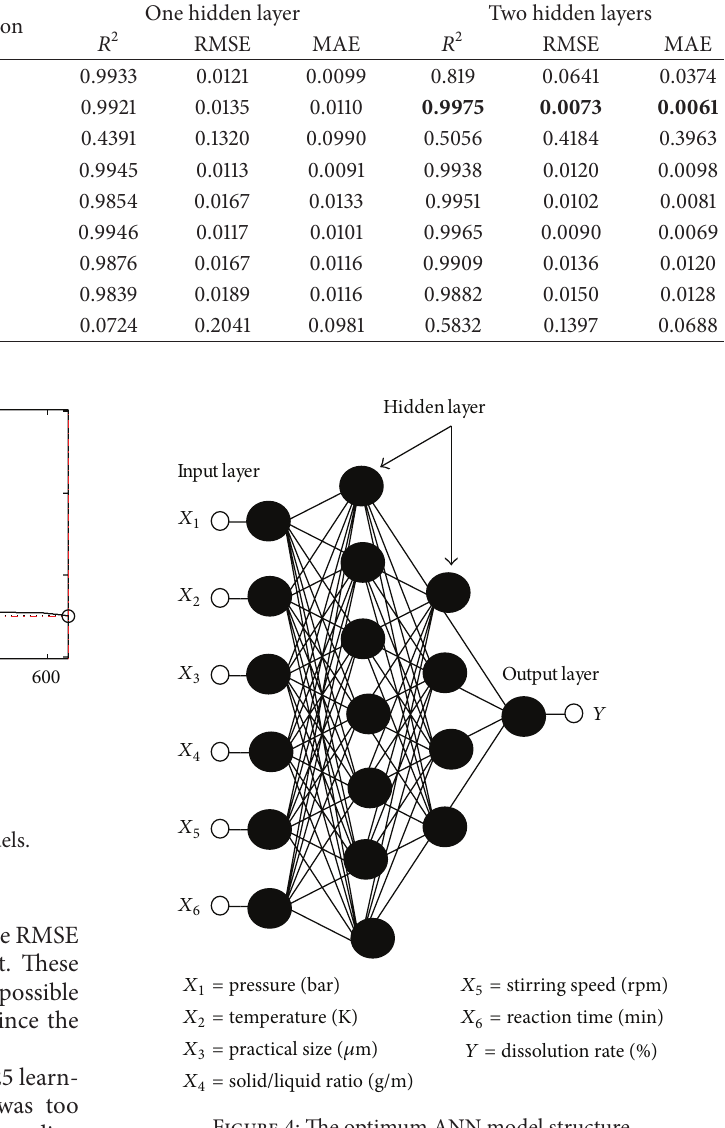
Table 3: Comparison of various backpropagation algorithms using different transfer function (test).